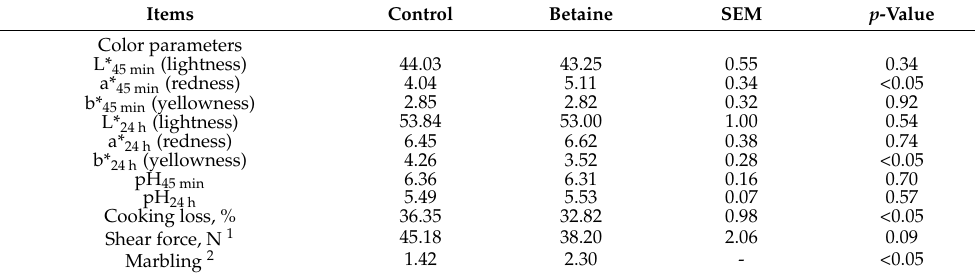
Table 3. Effects of betaine on meat quality in growing-finishing pigs.